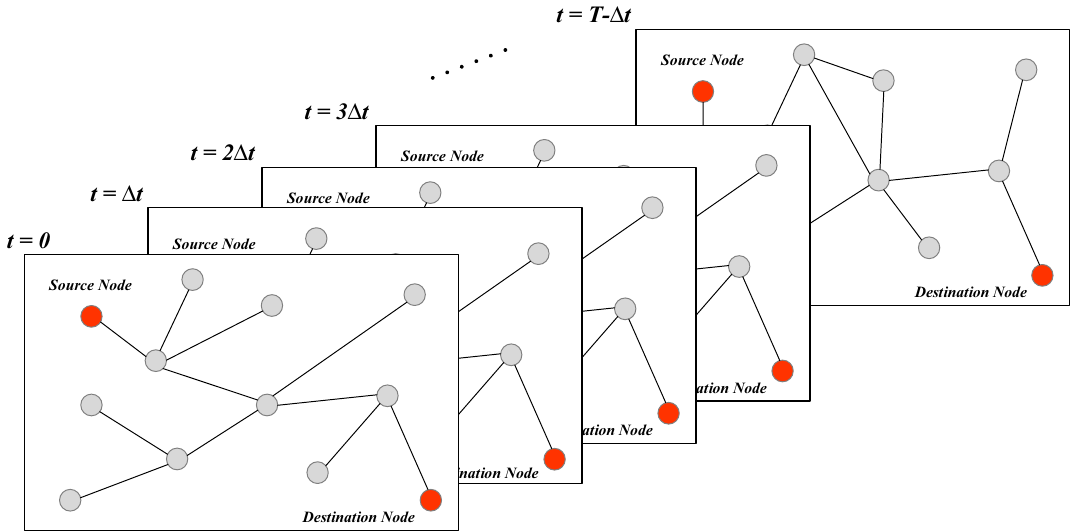
Figure 3. The virtual topology routing algorithm divides a period of the spatial information network T into a series of time